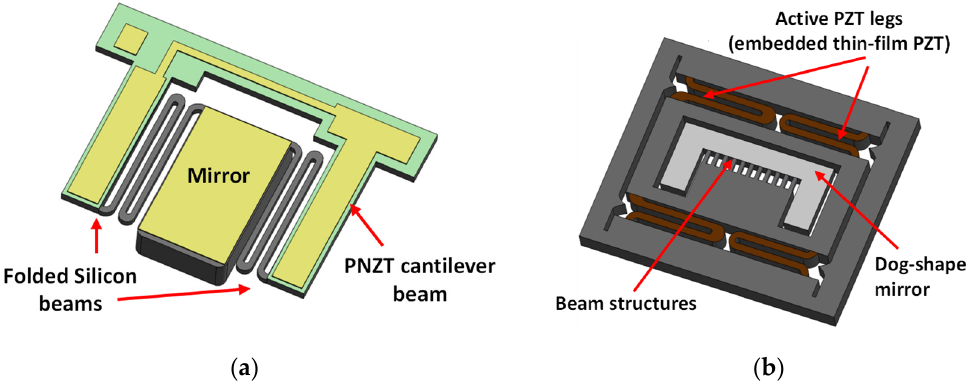
Figure 5. Mechanical structures of ( a ) the MEMS scanners indirectly actuated by a 13%-Nb-doped PZT (PNZT) cantilever beam [40]; ( b ) the MEMS scanners actuated by active lead zirconate titanate (PZT) legs to achieve the vertical translation and rotated by the mechanical couple into the gimbal platform [41].